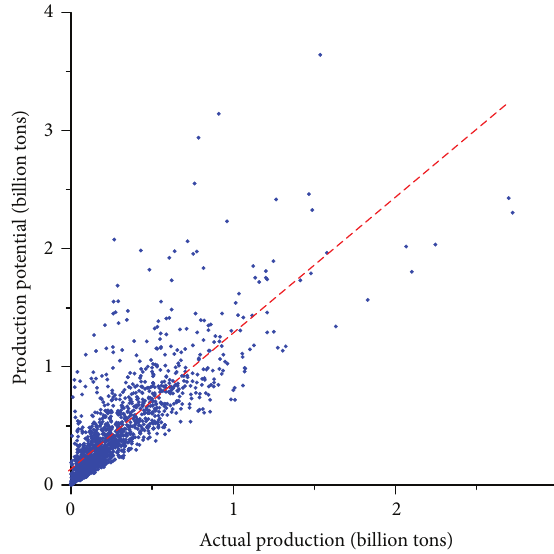
Figure 2: Correlation between production potential and actual production.